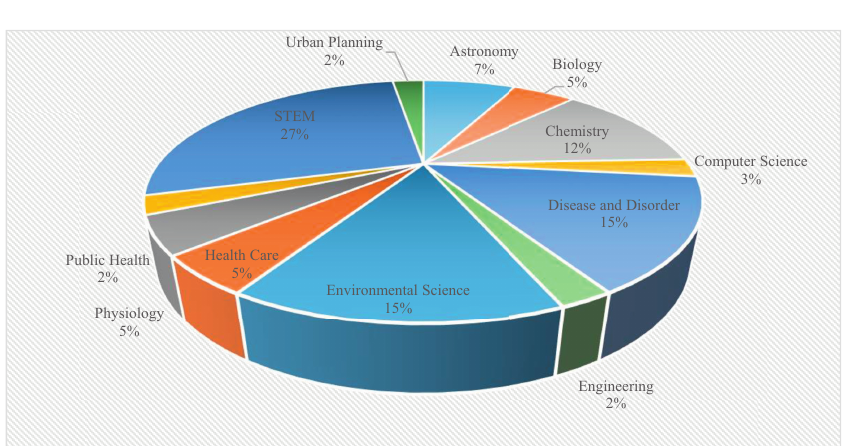
Figure 4. The STEM topics covered by the USA